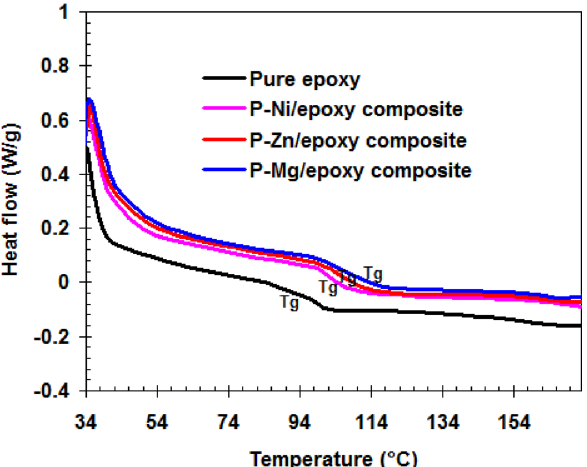
Figure 6. DSC thermograms for neat epoxy, P–Ni/epoxy, P–Zn/epoxy and P–Mg/epoxy